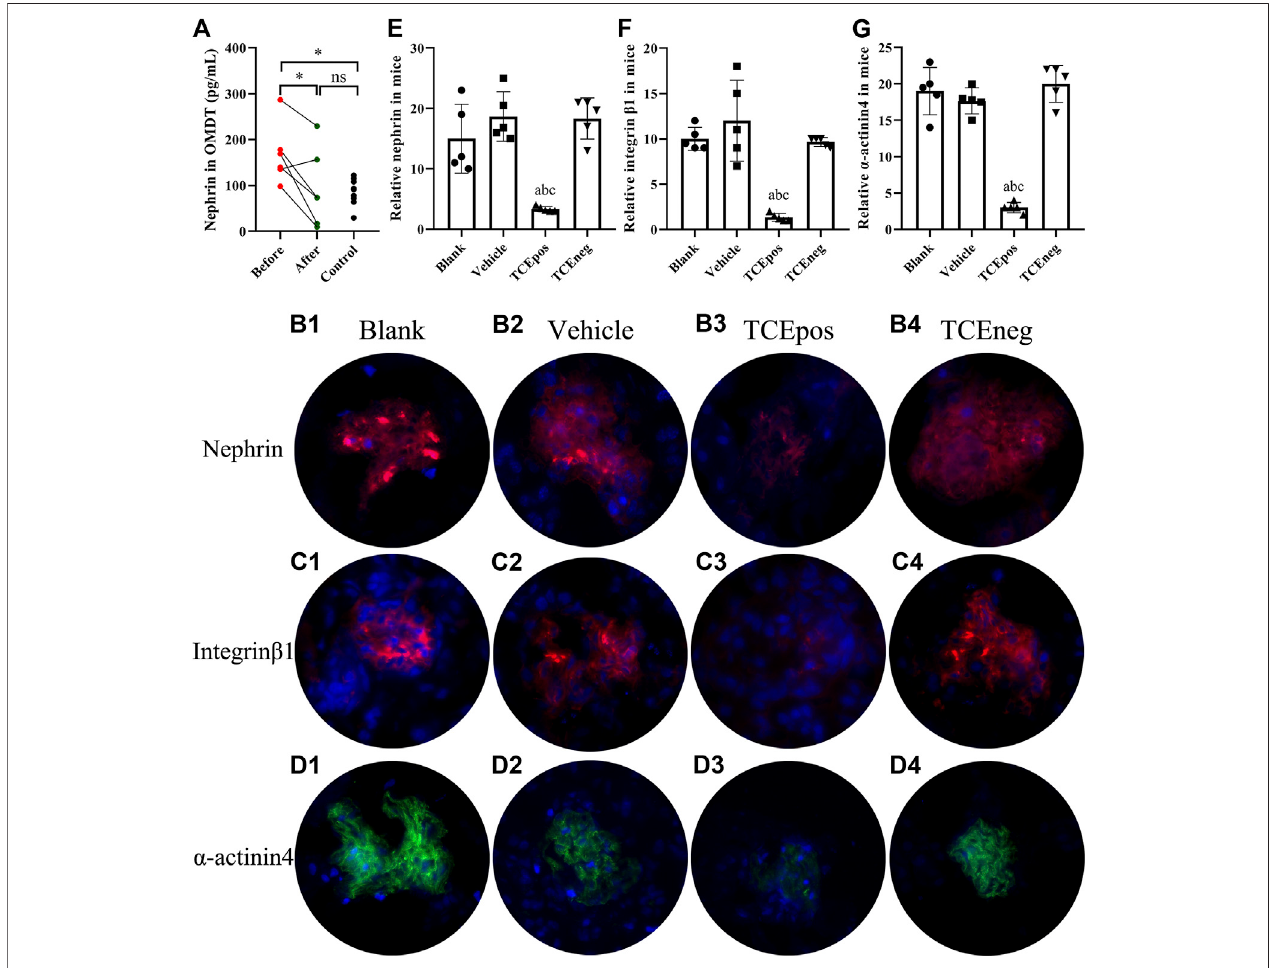
FIGURE 3 | Loss of podocytes occurred in OMDT patients and TCE-sensitized mice. (A) Expression of urine nephrin before and after clinical treatment in OMDT patients ( n (cid:1) 6). (B – D) Representative results of immuno fl uorescence test in mice ( n (cid:1) 5 per group). (B1 – B4) Expression of nephrin in blank control group (B1) , vehicle control group (B2) , TCEpos group (B3) , and TCEneg group (B4) . (C1 – C4) Expression of integrin β 1 in blank control group (C1) , vehicle control group (C2) , TCEpos group (C3) , and TCEneg group (C4) . (D1 – D4) Expression of α -actinin-4 in blank control group (D1) , vehicle control group (D2) , TCEpos group (D3) , and TCEneg group (D4) . (E-G) The fl uorescenceintensityofnephrin,integrin β 1,and α -actinin-4calculatedinImageJsoftware.Dataarepresentedasmean ± SDanddeterminedby paired t -test or one-way ANOVA, * p < 0.05, ns P > 0.05; a P < 0.05, vs. blank control group; b P < 0.05, vs. vehicle control group; c P < 0.05, vs. TCEneg